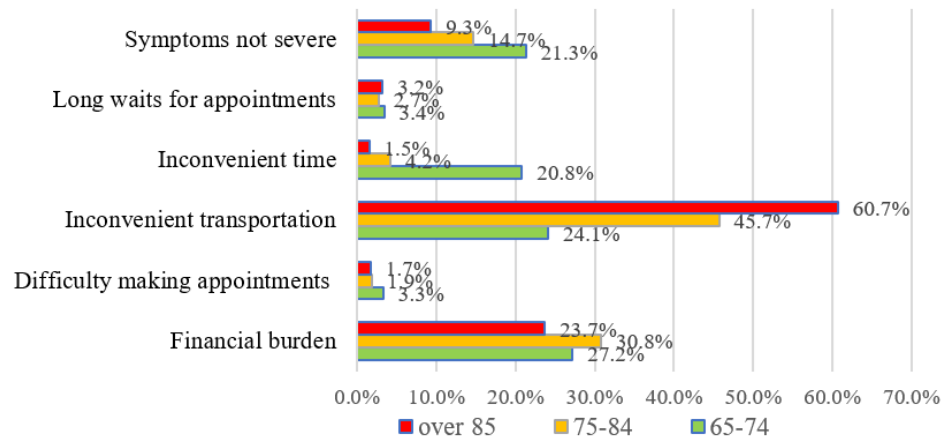
Figure 1. Reasons healthcare needs were not met according to age group.